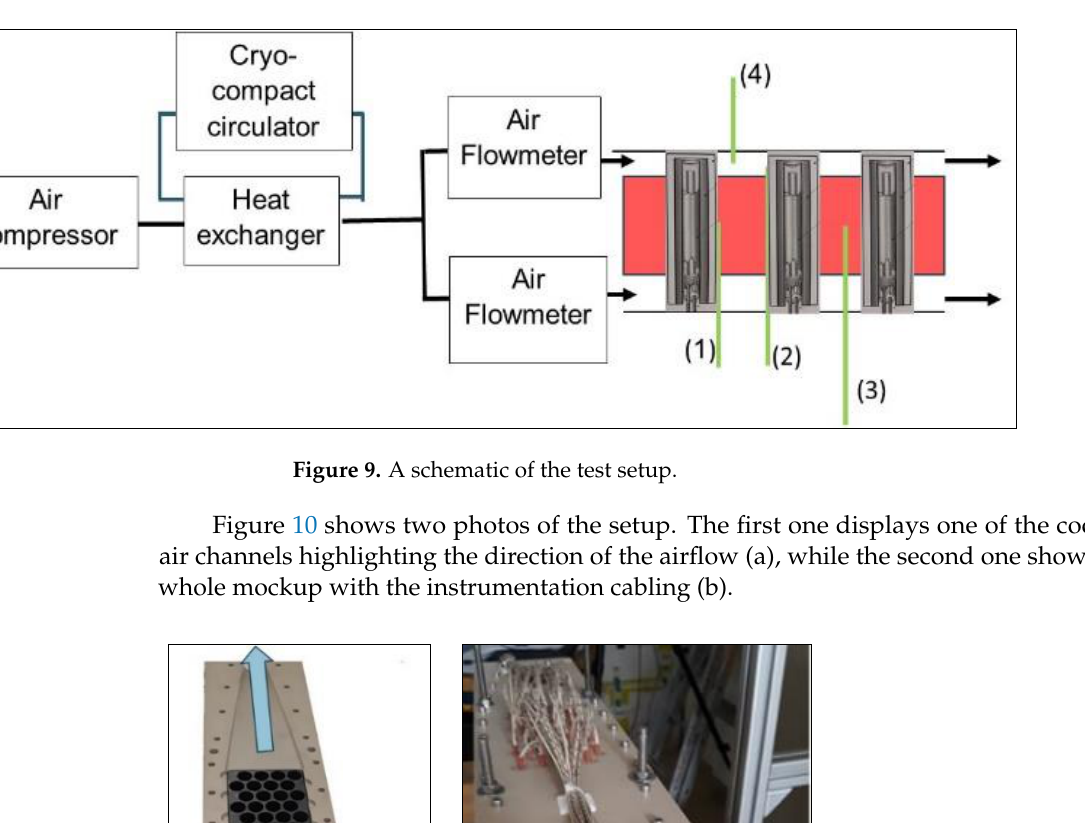
( b ) Figure 8. ( a ) Simulation domain of the CFD model implemented in ANSYS fluent and ( b ) battery cells temperature (in ℃ ) at the end of a charged/discharge cycle, without active cooling. 3.2. Experimental Setup To validate the calculations of the CFD model and to assess the actual performance of the PCM-EG matrix, an experimental setup and a mock-up of the battery pack were built. A schematic of the experimental setup is shown in Figure 9. The prescribed temper- ature of the cooling air mass flow rate was attained in all operating conditions via a heat exchanger located downstream of the air compressor. The mockup was instrumented as follows: •